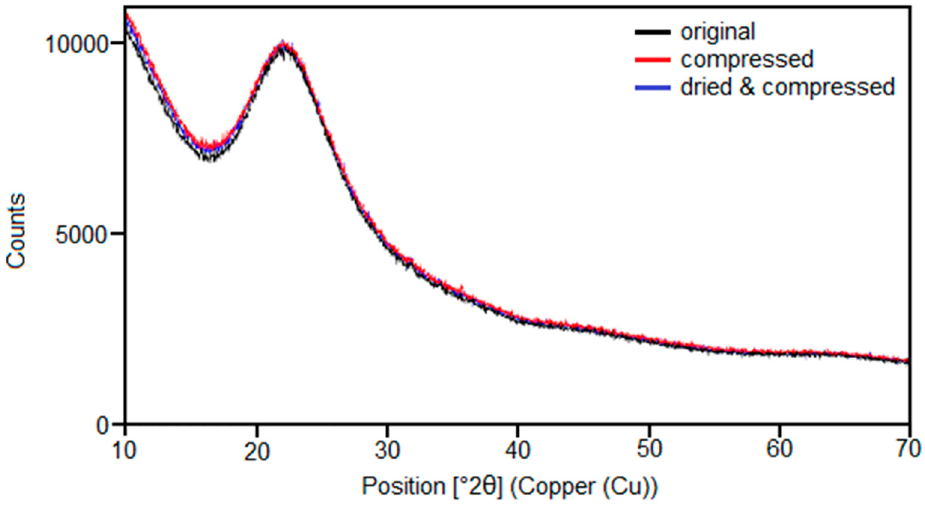
Figure 10. X-ray diffraction measurement of one type of silica as the reference, after compression up to 125 MPa and after drying (105 °C for 2 h) and compression.